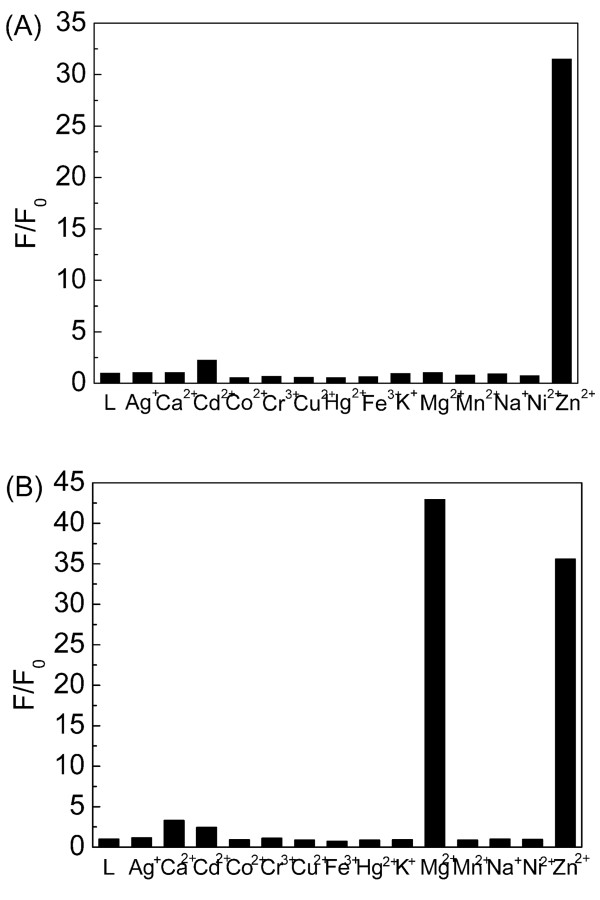
Fluorescence response of DTH-Fe3O4@SiO2 (A) and DTH (B) to various cations. Excitation wavelength was 397 nm. Spectra were recorded every 25 min after adding Zn2+.